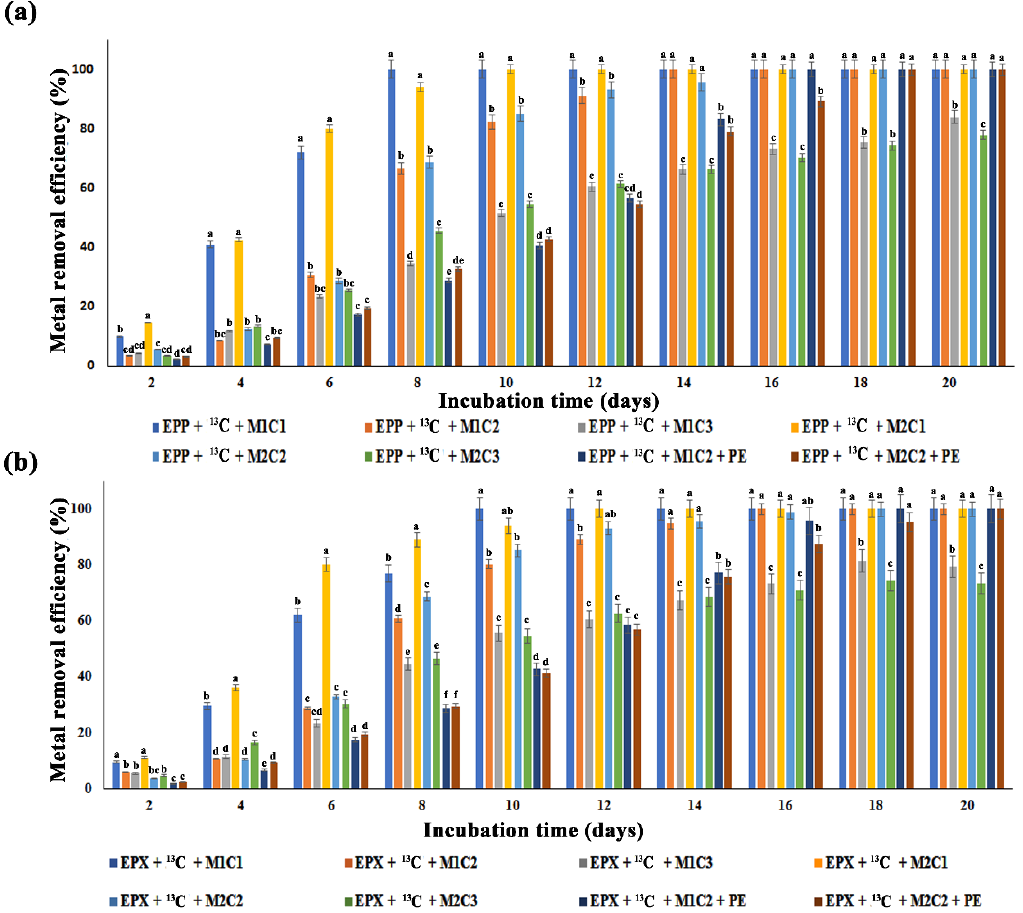
Figure 3. Heavy metals (HMs) removal e ffi ciency over a period of 20 days. ( a ) Epiphyton (EPP) HMs removal e ffi ciency under three metals concentrations (C1 = 2 mg / L, C2 = 50mg / L, C3 = 100 mg / L) of Pb 2 + (M1) and Cd 2 + (M2) along with a combination of PE, Pb 2 + (M1), and Cd 2 + (M2) at various concentrations C2 of 50 mg / L; ( b ) Epixylon (EPX) HMs removal e ffi ciency under three metals concentrations (C1 = 2 mg / L, C2 = 50 mg / L, C3 = 100 mg / L) of Pb 2 + (M1) and Cd 2 + (M2) along with a combination of PE, Pb 2 + (M1), and Cd 2 + (M2) at concentration C2 = 50 mg / L. Data are expressed as mean ± standard error. The data in a column with a di ff erent letter di ff er significantly ( p < 0.05) within treatments at the same day of collection based on Duncan’s